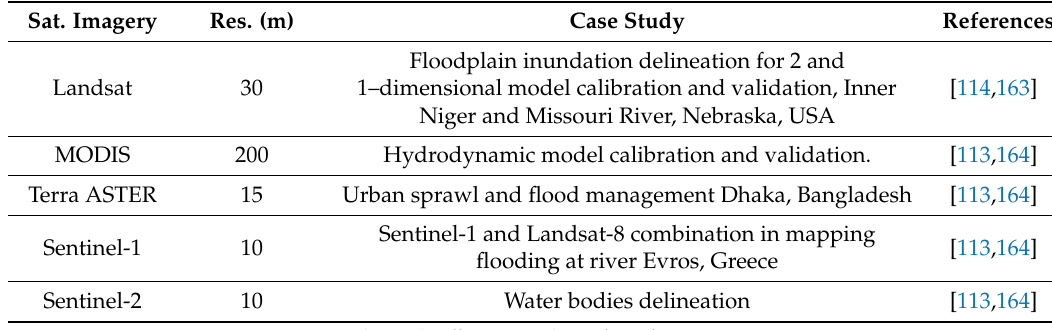
Table 6. Optical and radar satellite imageries case studies.